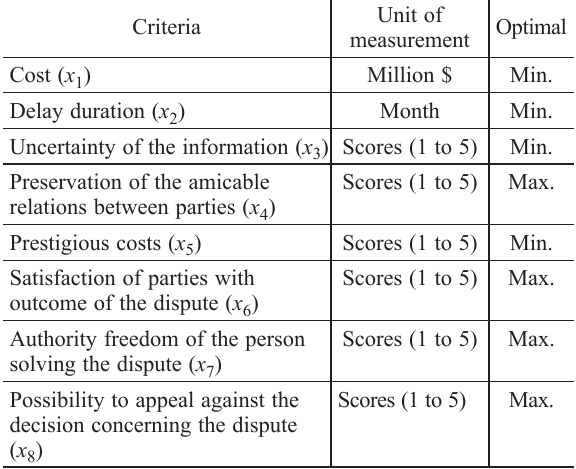
Table 1. Criteria of the dispute resolution of the delay problem